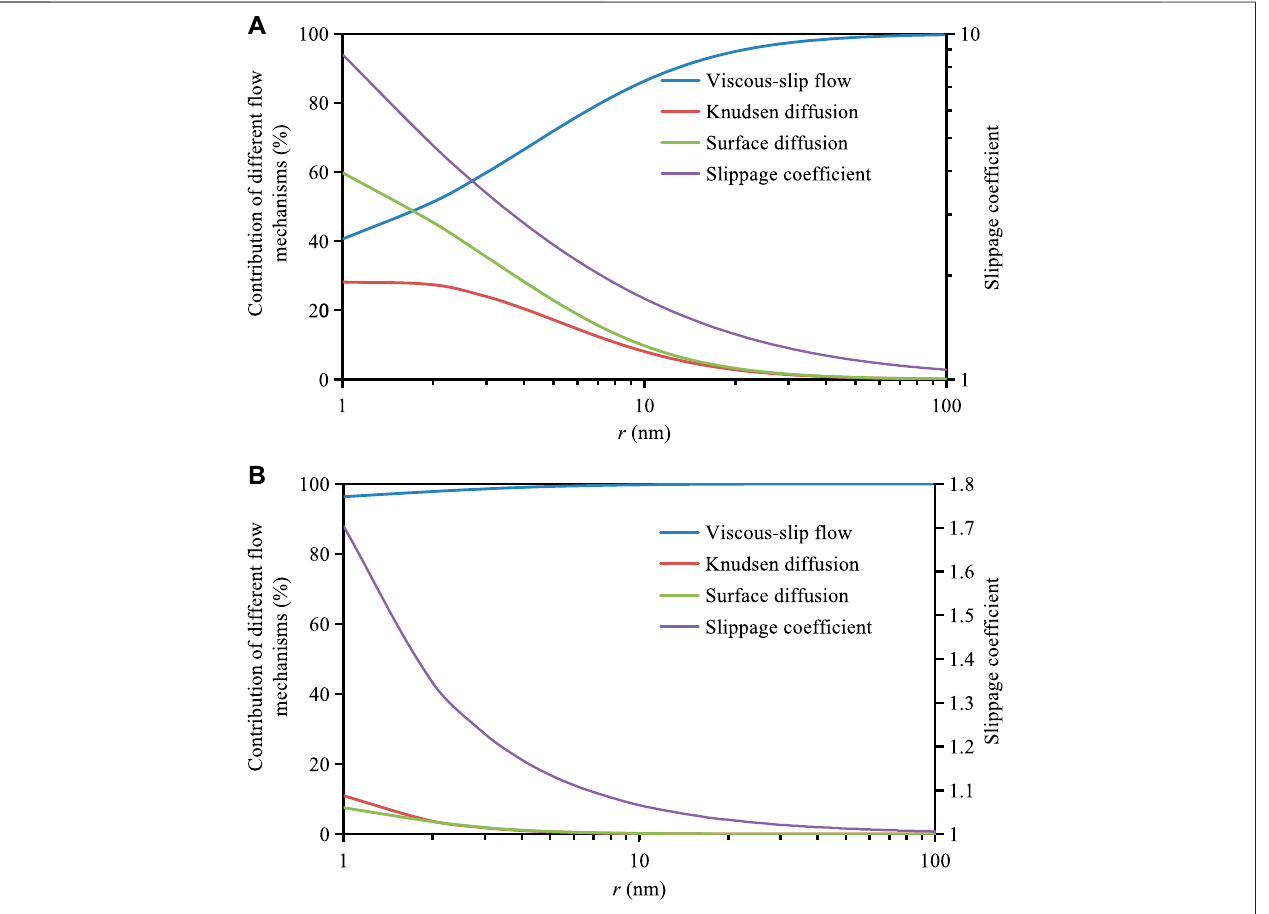
FIGURE 3 | (A) Percentage contribution of different fl ow mechanisms to the apparent permeability ( p (cid:1) 3 MPa). (B) Percentage contribution of different fl ow mechanisms to the apparent permeability ( p (cid:1) 30 MPa).